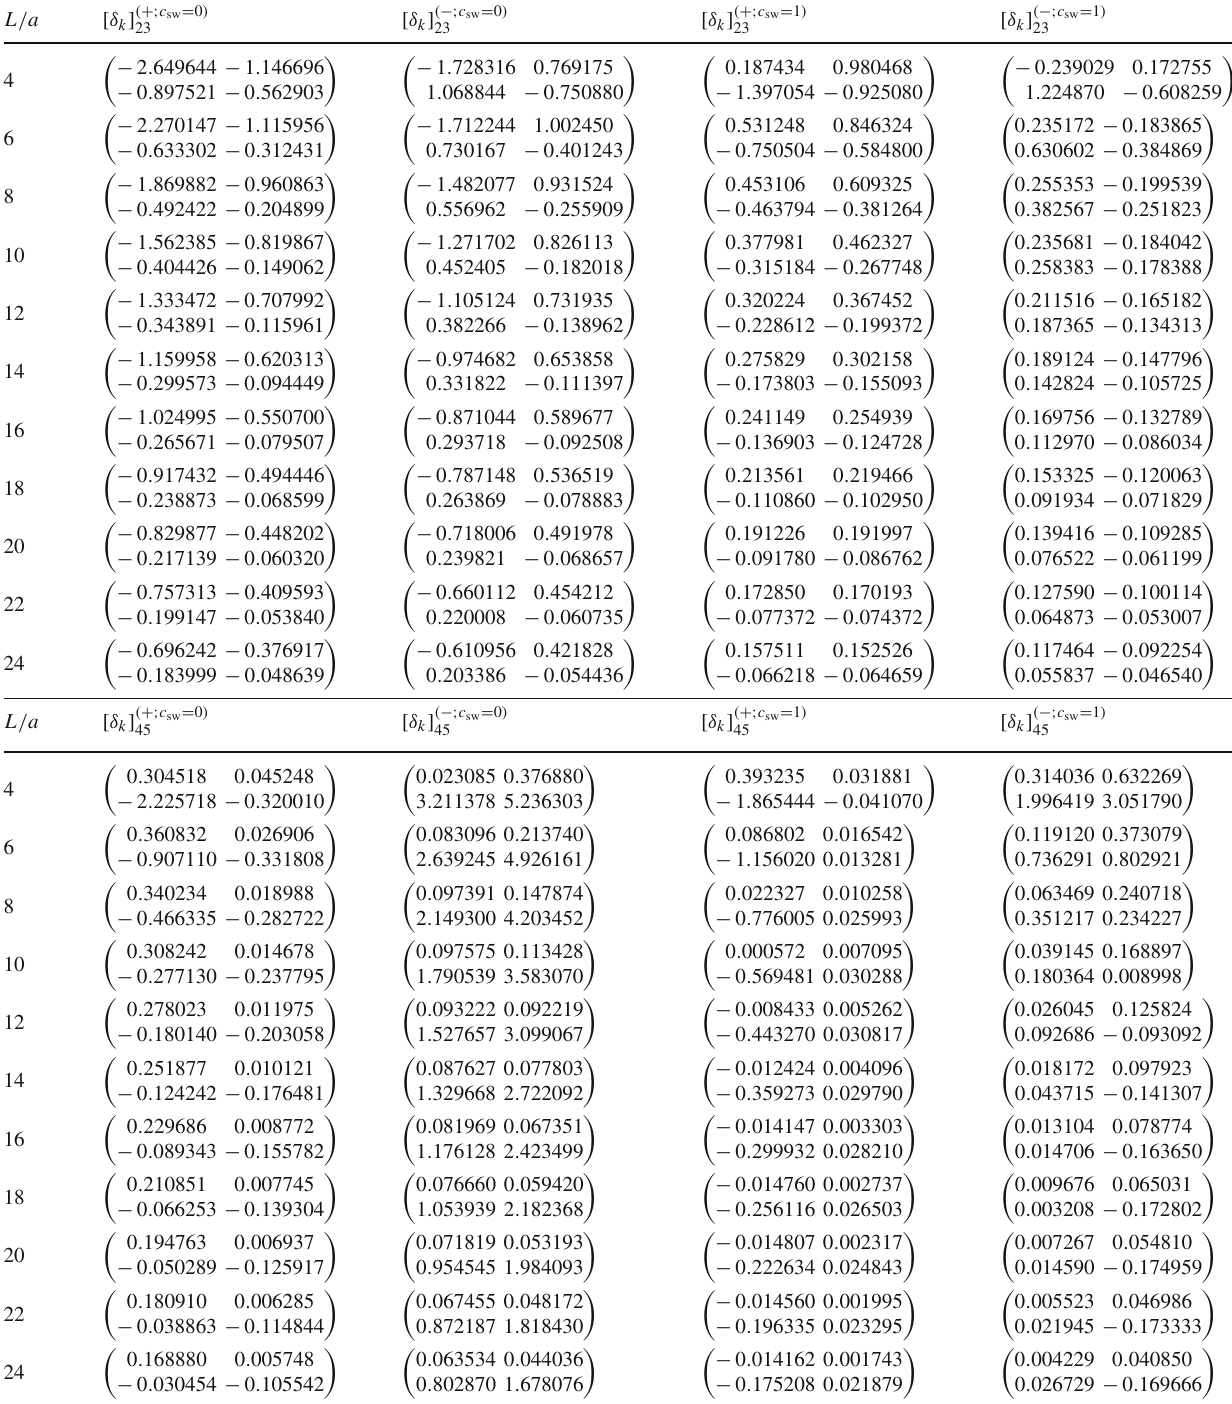
Table 9 Matrix elements of δ k ( L / a ) for the SF scheme with α = 3 / 2 and ( s 1 , s 2 ) = ( 3 , 5 ) L / a [ δ k ] ( +; c sw = 0 )